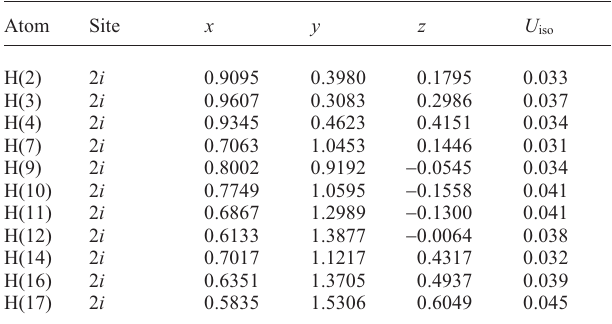
Table 2. Atomic coordinates and displacement parameters (in Å 2 )